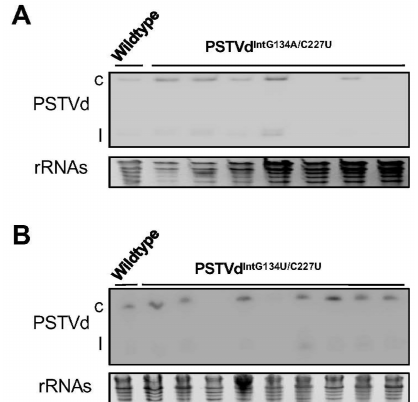
Figure 4. Infection assay showing the trafficking capacity of loop 19* and loop 19 (cid:48) . ( A ) Northern blots showed the accumulation of loop 19* (PSTVd IntG134A/C227U ) in systemic leaves; ( B ) Northern blots showed the accumulation of loop 19 (cid:48) (PSTVd IntG134A/C227U ) in systemic leaves. rRNAs served as the loading control. c, circular PSTVd. l, linear PSTVd.